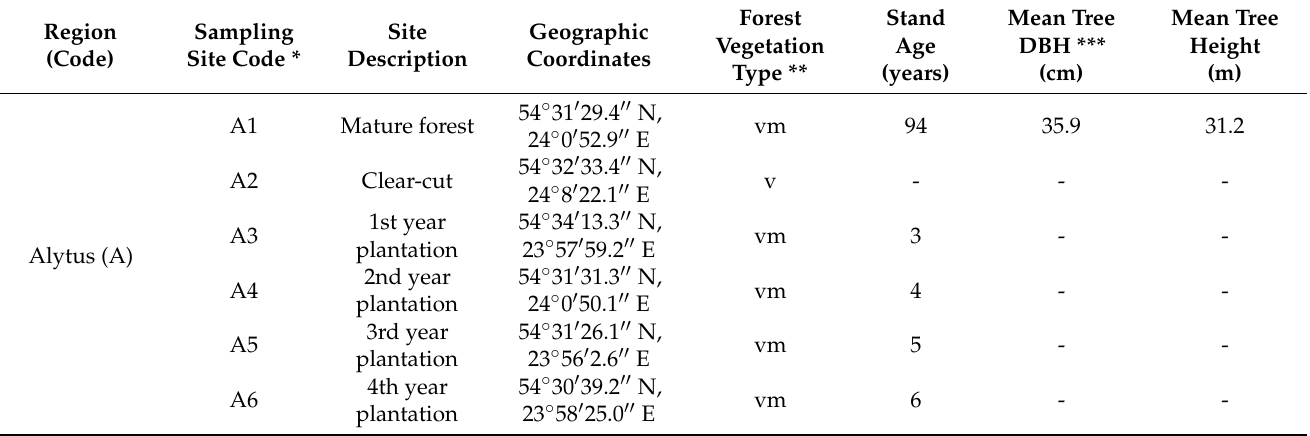
Table 1. Characteristics of the sampling sites in the selected Pinus sylvestris L. stands according to the State Forest Cadastre